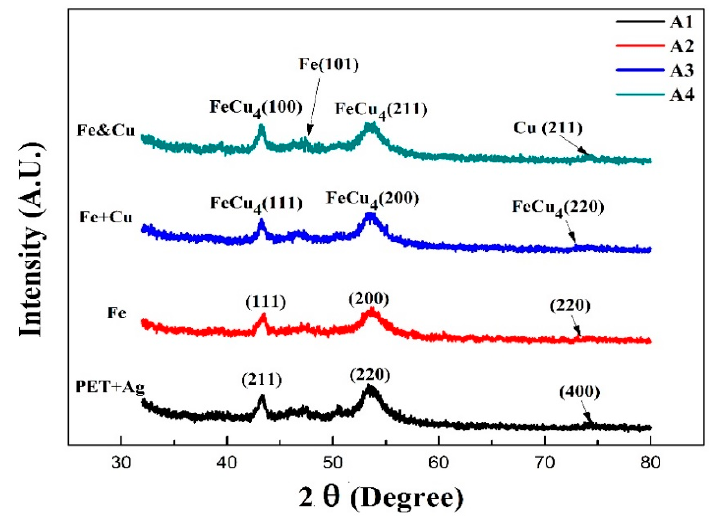
Figure 2. XRD pattern of the Cu-dopped nano structured iron thin films.